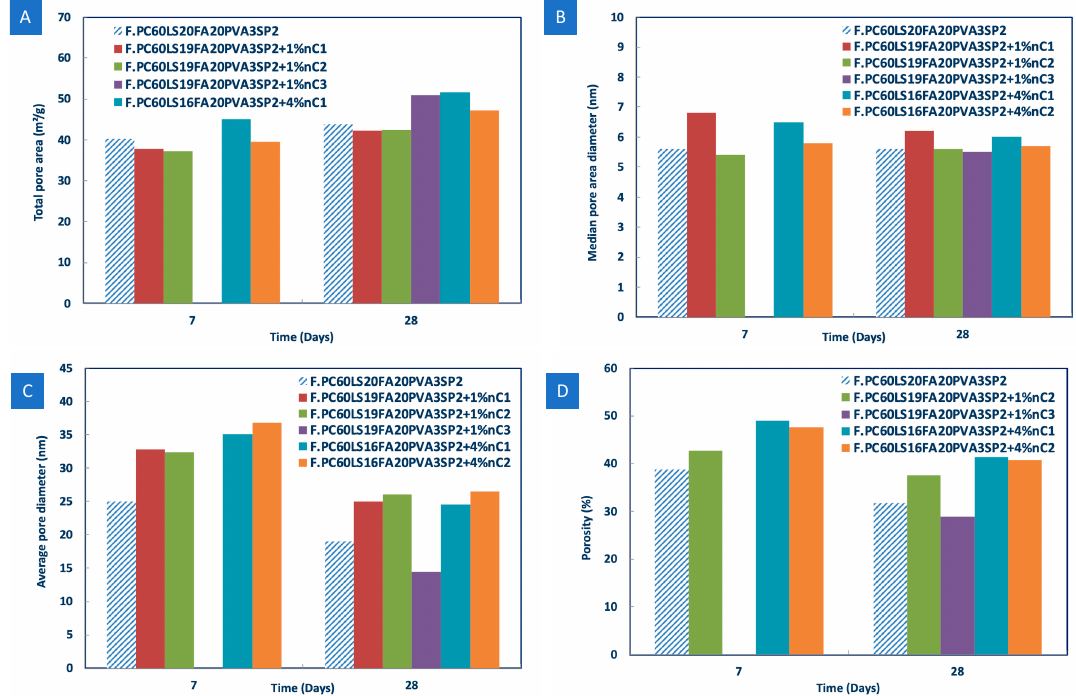
Figure 15. Effect of nMt type on ( A ) the total pore area, ( B ) the median pore area diameter, ( C ) the average pore diameter and ( D ) the porosity of fibre cements.